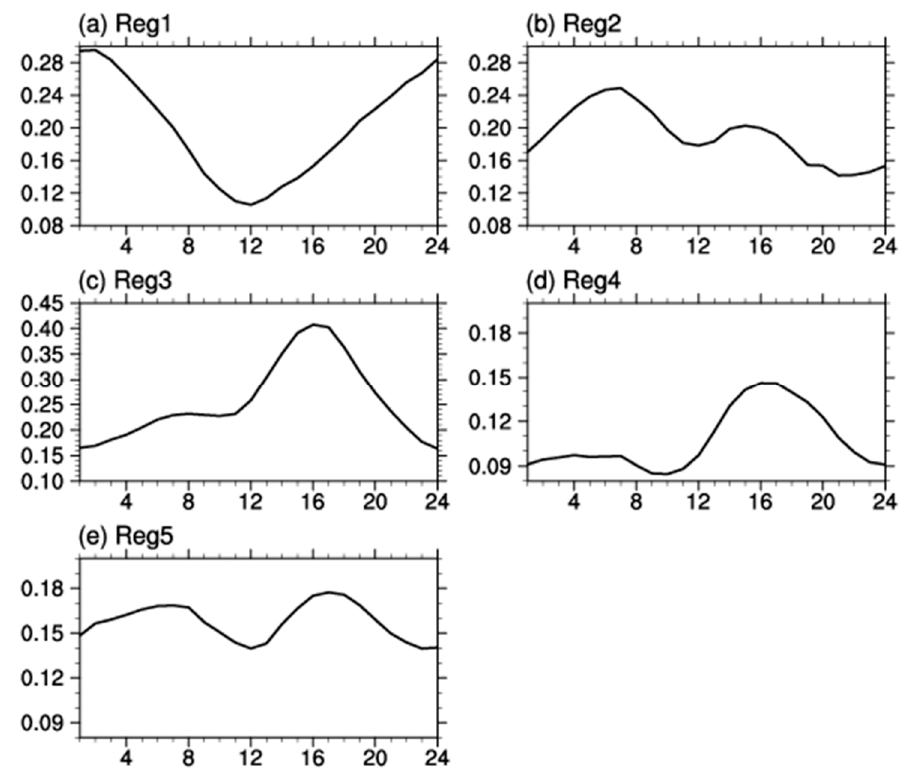
Figure 6. Diurnal variation of the 2008–2011 mean summer precipitation averaged over the five regions in Table 1 (the horizontal axis corresponds to the local solar time, units: mm/h).